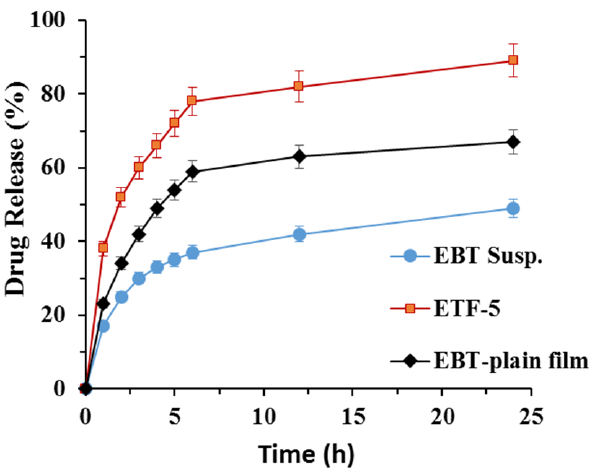
Figure 8. Cumulative in vitro drug release (%) from EBT suspension, EBT plain film and optimized formulation ETF-5.